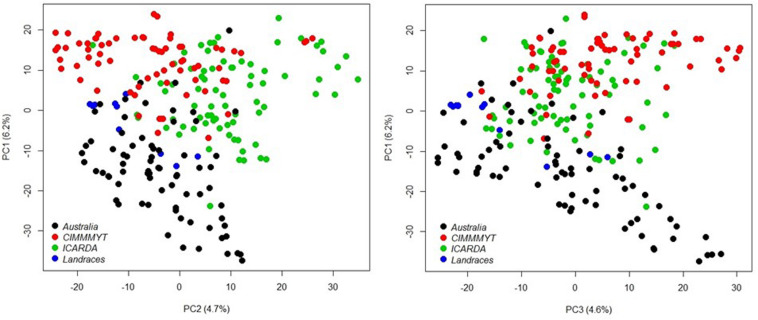
Principal component analysis of 232 wheat genotypes using 20,563 markers filtered from the 90K Infinium SNP chip array. Different colors represent genotype origins: black, Australian cultivars; red, CIMMYT inbred lines; and green, ICARDA inbred lines and blue, landraces.